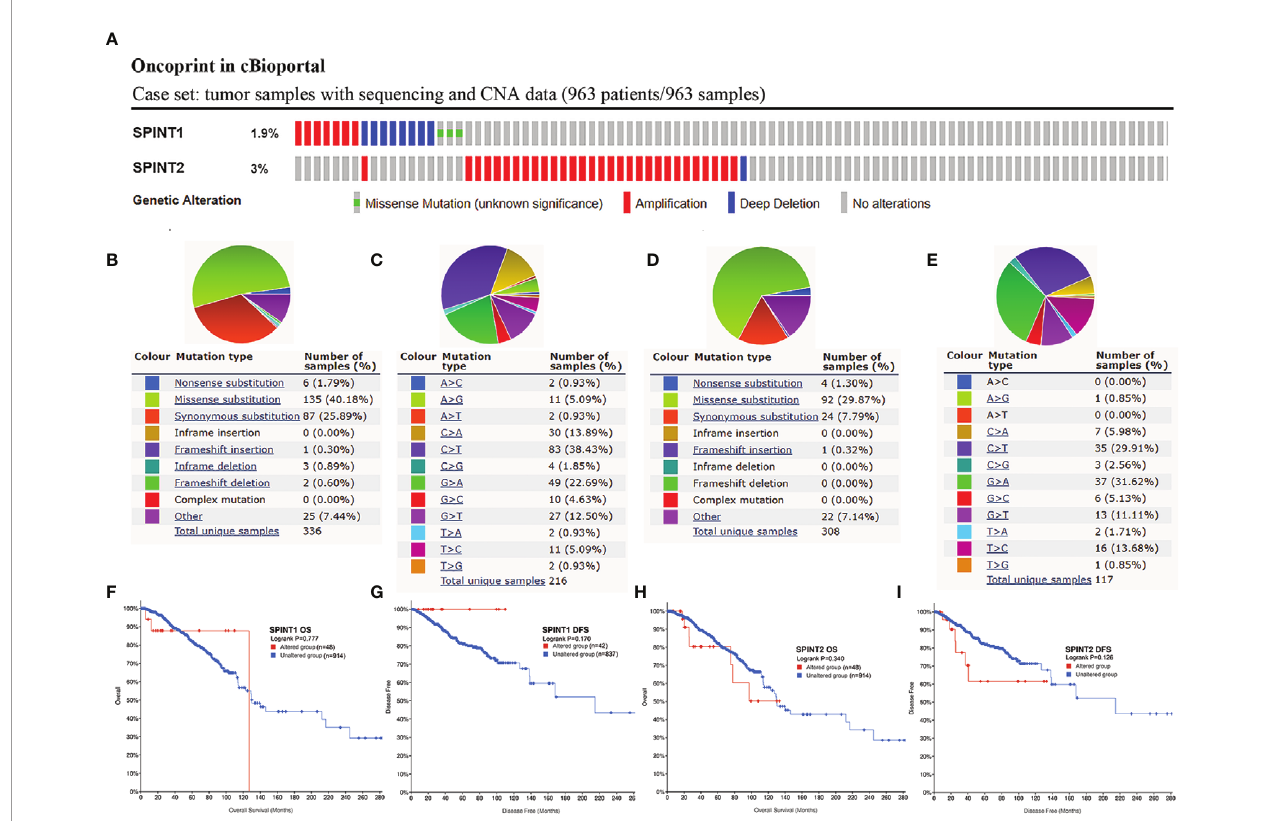
FIGURE 5 | Genetic alteration frequency of SPINT1/2 was low and not related to prognosis. Genetic mutations in SPINT1/2 (A) , mutation subtypes distribution of SPINT1 (B) , nucleotide changes in SPINT1 (C) . Alteration subtypes of SPINT2 (D) , nucleotide changes of SPINT2 (E) . The correlation between SPINT1 gene alteration and OS (F) and DFS ( G ). The correlation between SPINT2 gene alteration and OS (H) and DFS (I)